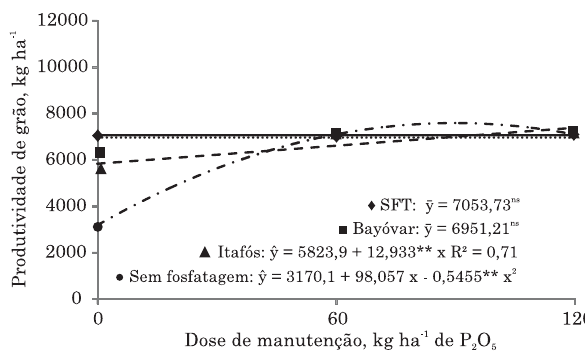
Figura 4. Produtividade de grãos de milho cultivado em um Cambissolo sergipano no segundo ano de cultivo (efeito residual) em função da adubação fosfatada corretiva e das doses de manutenção. ns e **: não significativo e significativo a 1 %,